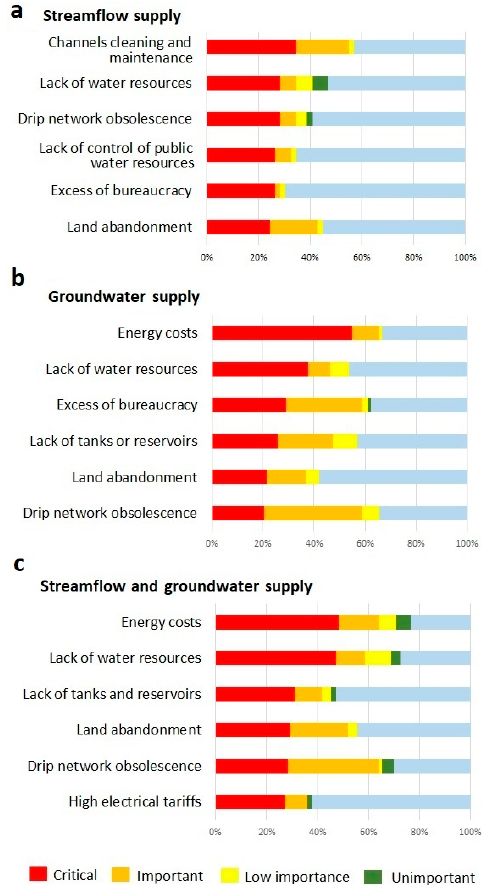
Figure 5. Problem assessment according to different water supply sources: evaluated in terms of percentage of total votes. ( a ) Streamflow supply; ( b ) Groundwater supply; ( c ) Mixed streamflow and groundwater